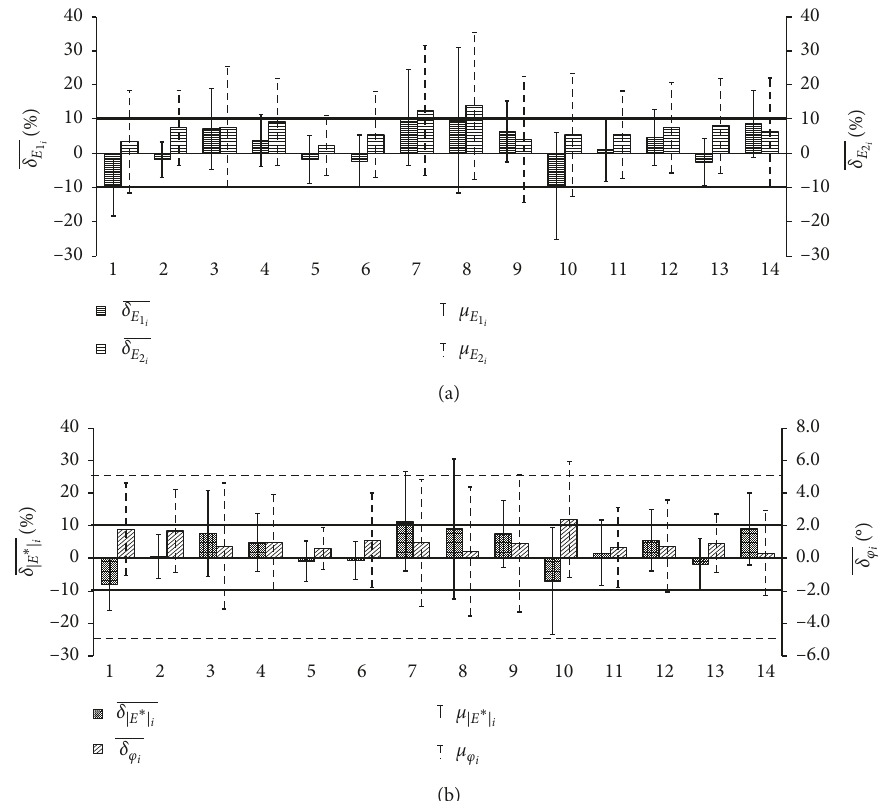
Figure 12: Histograms of global errors of 2S2P1D model fitting of all users for the bituminous mixture (Figure 9), calculated according to equations (34)–(37): (a) relative errors for E 1 and E 2 ( δ E ( δ φ ). Error bars are plotted according to standard deviations μ E i